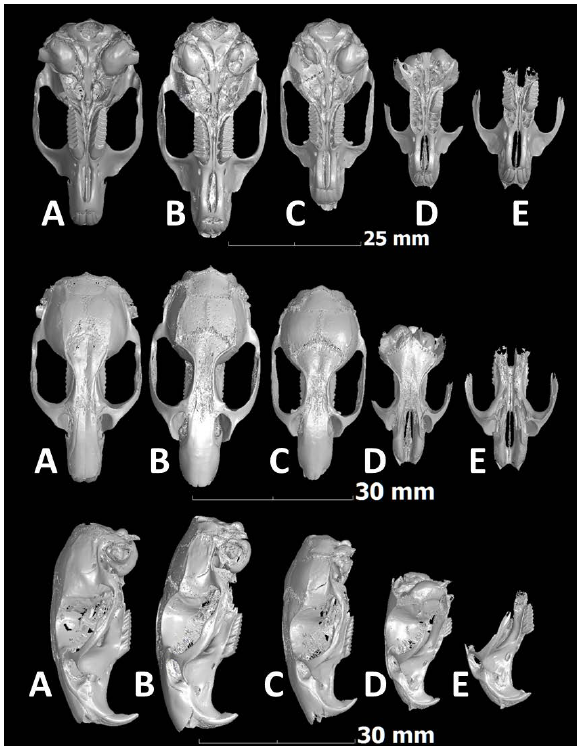
Figure 3: Comparison between the skulls of Otomys sloggetti , O. irroratus, O. karoensis, and two Otomys taxa from modern owl pellet collections in ventral (top), dorsal (middle) and left lateral (bottom) view: (A) O. sloggetti (TM–16519B), (B) O. irroratus (ZM–82140), (C) O. karoensis (ZM–37374), (D) Otomys sp. De Hoop Collections Cool Room roost site (DHC–10–3), (E) Otomys sp. Elandspad bulk pellet sample (EPF–bulk–1).